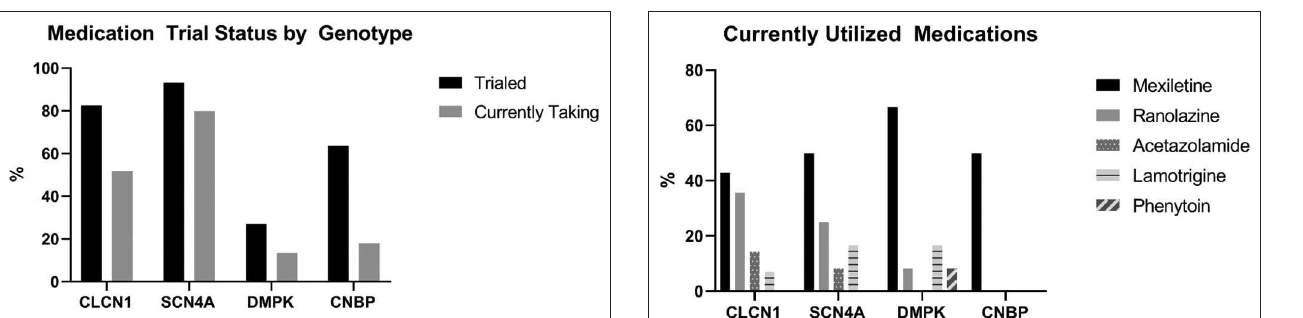
= 16) and side effects (20%, n = 10). For mexiletine, reason